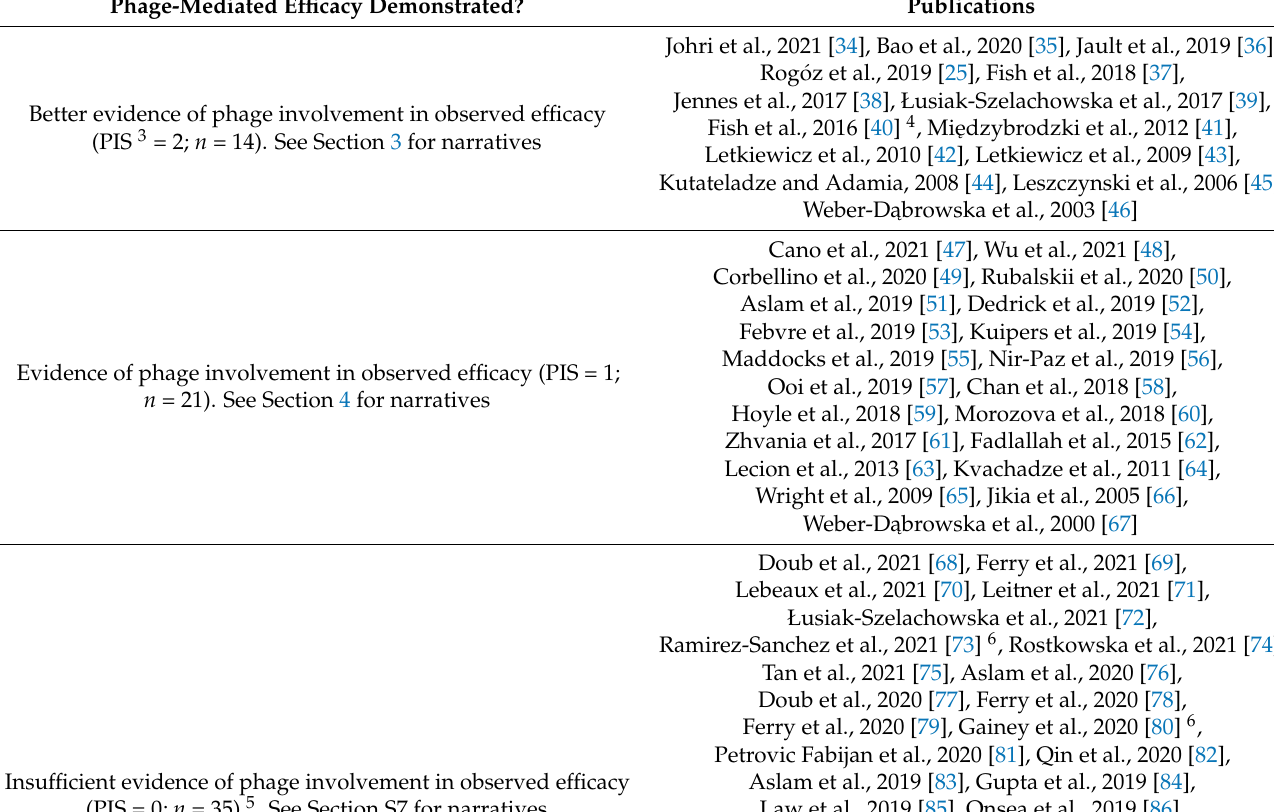
Table 1. Proposed Study Contributions to Evidence of Phage-Mediated Clinical Efficacy 1,2